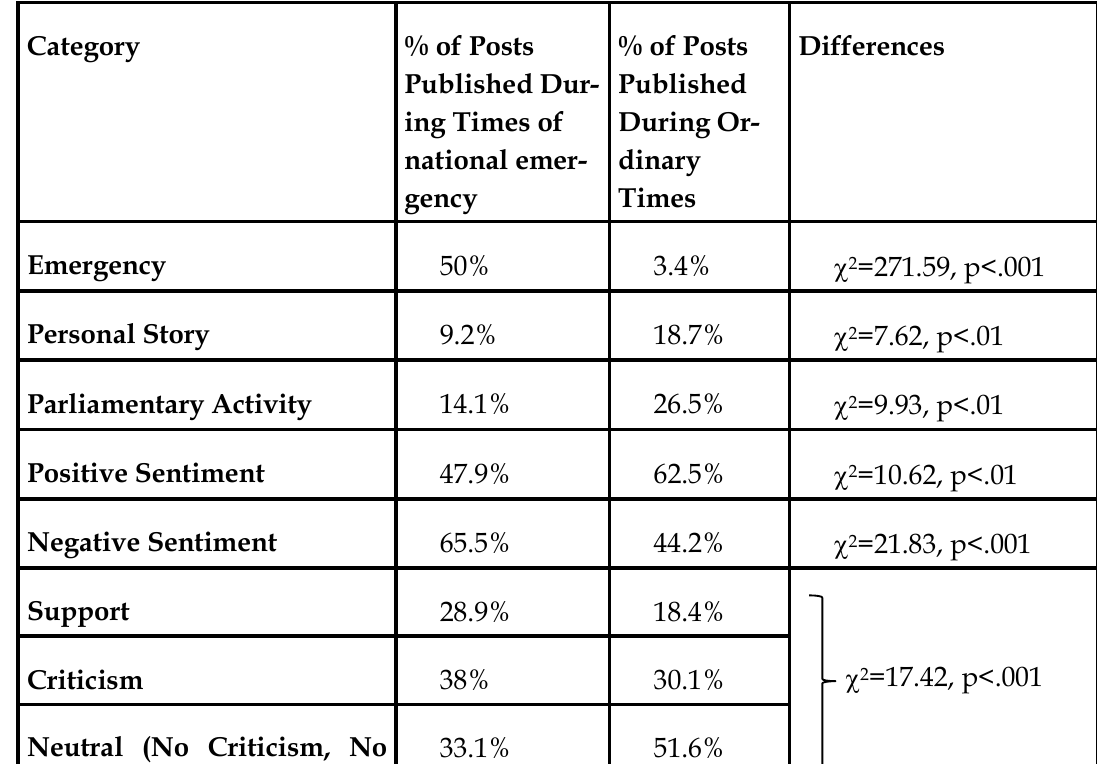
Table 2. Differences between content of ordinary and emergency